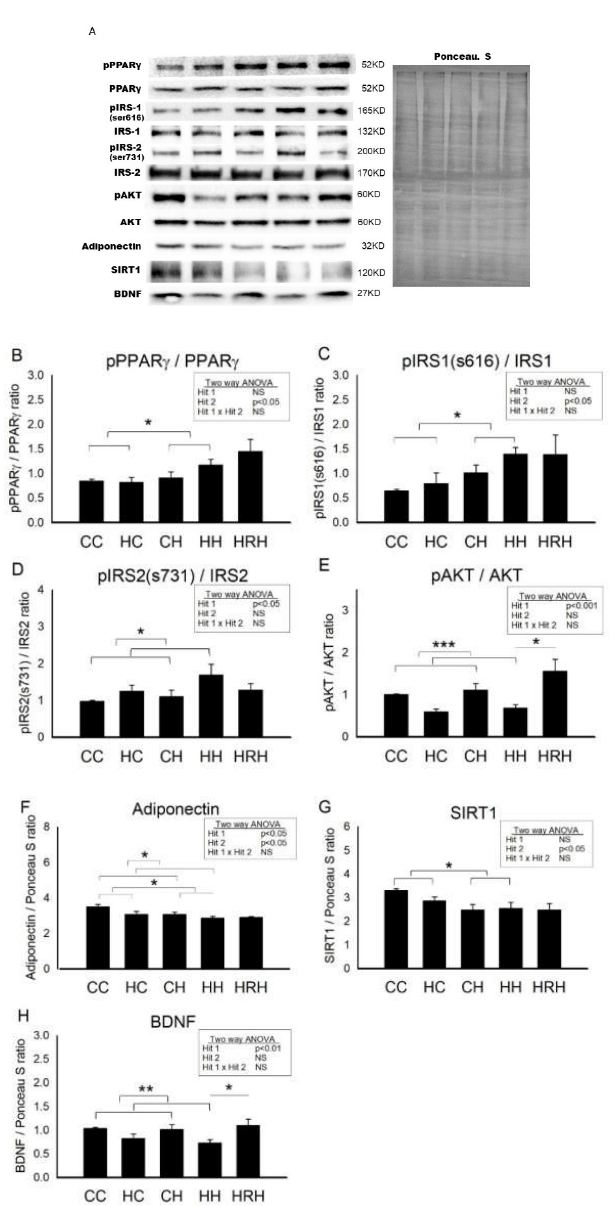
Figure 7. Targeted protein levels in rat dorsal hippocampus at 4 months old. The levels of dorsal hippocampus targeted proteins were detected via Western blotting and normalized using Ponceau S staining. ( A ) Representative band densities are shown. Relative abundance of ( B ) pPPARγ/PPARγ, ( C ) pIRS1 (s616)/IRS1, ( D ) pIRS2 (s731)/IRS2, ( E ) pAKT/AKT, ( F ) adiponectin, ( G ) SIRT1, and ( H ) BDNF were quantified. One-way ANOVA followed by Fisher’s LSD post hoc was used to assess the significant differences among groups and multiple comparisons. pPPARγ/PPARγ: postnatal HFD treatment (F (1,36) = 4.170, p < 0.05). pIRS(s616)/IRS1: postnatal HFD treatment (F (1,28) = 6.817, p < 0.05). pIRS2 (s731)/IRS2: maternal HFD/obesity treatment (F (1,24) = 5.094, p < 0.05). pAKT/AKT: maternal HFD / obesity treatment (F (1,28) = 20.507, p < 0.001). Adiponectin: maternal HFD / obesity (F (1,32) = 5.187, p < 0.05); postnatal HFD treatment (F (1,32) = 4.941, p < 0.05). SIRT1: postnatal HFD treatment (F (1,44) = 8.475, p < 0.01). BDNF: maternal HFD / obesity treatment (F (1,44) = 11.145, p < 0.01). n = 10–12 for each group. * p < 0.05; ** p < 0.01; *** p < 0.001. PPAR γ : peroxisome proliferator-activated receptors γ ; IRS: insulin receptor substrate; AKT: alpha serine / threonine-protein kinase; SIRT1: sirtuin 1; BDNF: brain-derived neurotrophic